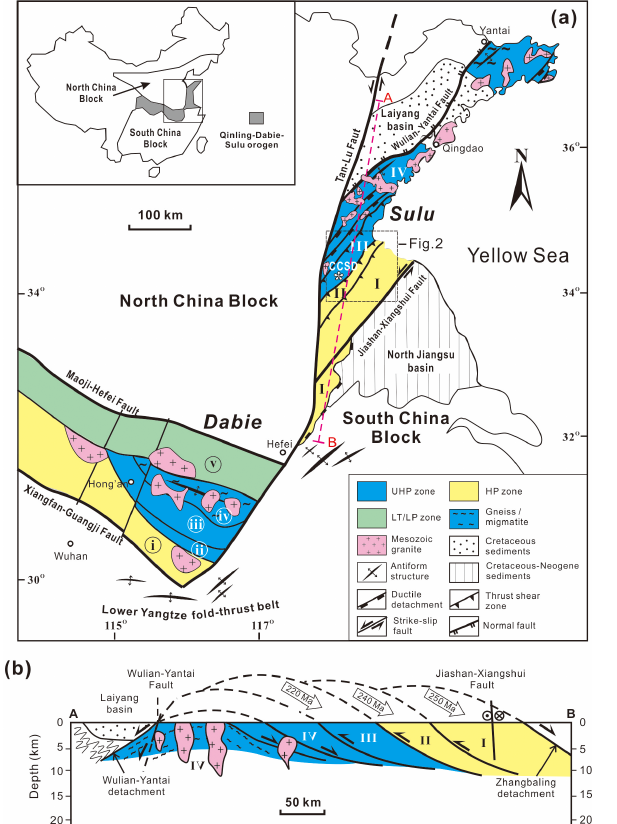
Figure 2. (a) Simplified geological map of the Dabie–Sulu oro- genic belt and (b) cross section of the Sulu Terrane (modified after Xu et al., 2009b). The Sulu Terrane consists of four im- bricate tectonic slices with different temperature ( T ) and pres- sure ( P ) conditions: I, southern low-T/high pressure (HP) glauco- phane zone; II, central mid-T/HP kyanite zone; III, northern mid- T/ultrahigh-pressure (UHP) supracrustal zone; IV, northern high- T/UHP granitic zone. The Dabie Mountains consists of five zones from south to north: i, Susong low-T/HP blueschist facies zone; ii, south Dabie low-T/UHP zone; iii, central Dabie mid-T/UHP zone; iv, north Dabie high-T/UHP zone; v, Beihuaiyang low-T/low- P greenschist facies zone. Star denotes the drilling site of the CCSD- MH. Open arrows indicate top-to-the-northwest shearing related to exhumation of the Sulu Terrane, with the starting age of exhumation for different